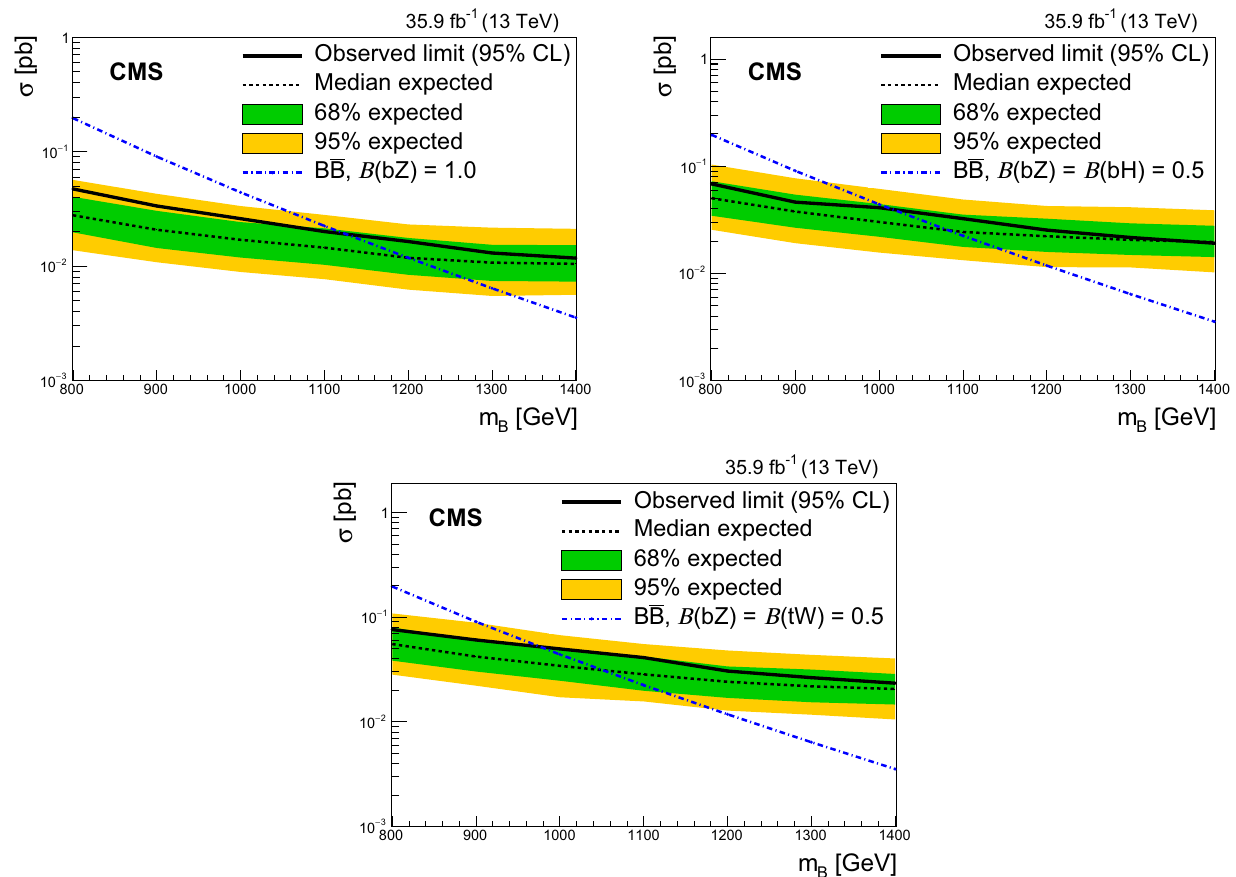
Fig. 7 The observed (solid line) and expected (dashed line) 95% CL upperlimitsontheBBproductioncrosssectionversustheBquarkmass for (upper left) B ( B → bZ ) = 100%, (upper right) B ( B → bZ ) = B ( B → bH ) = 50%, and (lower) B ( B → bZ ) = B ( B → tW ) = 50%.